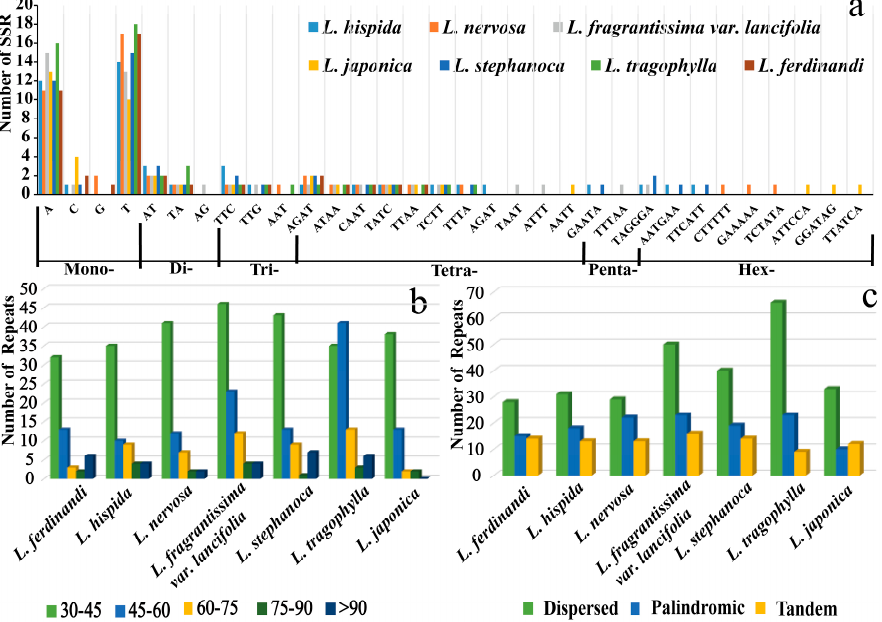
Figure 3. Analysis of repeated sequences in the seven Lonicera chloroplast genomes. ( a ) Frequency of selected motifs of simple sequence repeats (SSRs); ( b ) Frequency of repeat sequences of length >30 bp; ( c ) Composition of the repeats in seven Lonicera species.